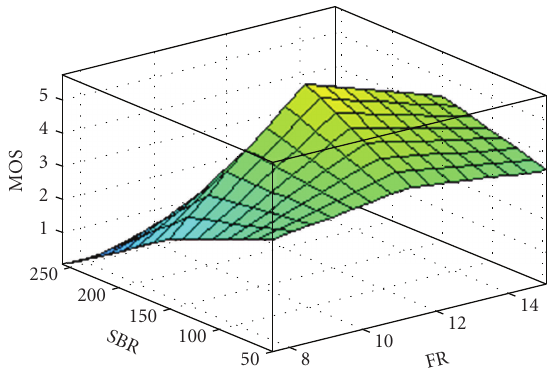
Figure 20: MOS versus SBR versus FR for the three content types.